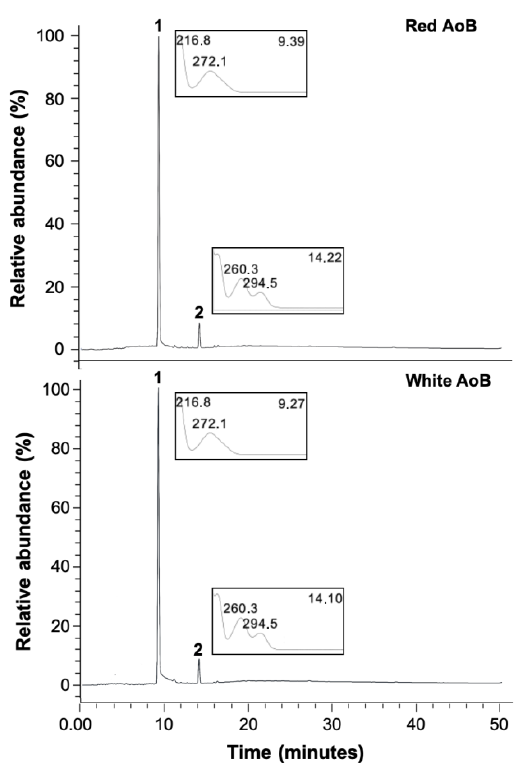
Figure 5. Representative LC-UV/DAD chromatographic profiles for the red and white AoBs. 1: gallic acid; 2: protocatechuic acid.